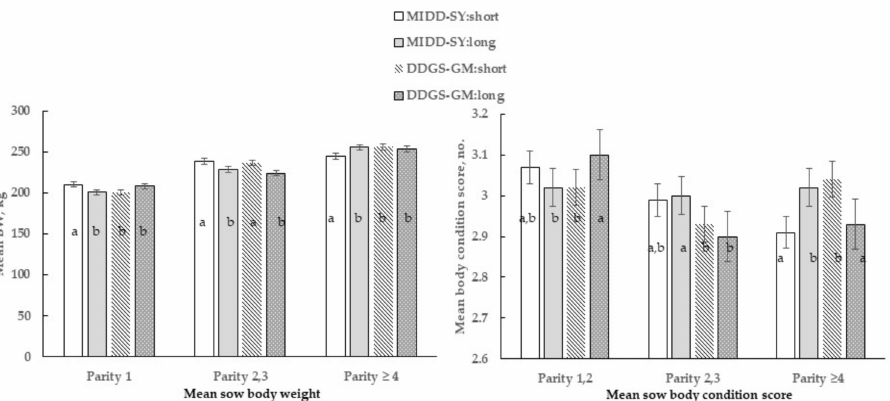
Figure 2. Three-way interactive effect of parity by diet by length on mean sow body weight (BW) and mean body condition scores for group pen sows. Within parity bars with different letters differ at p < 0.05.